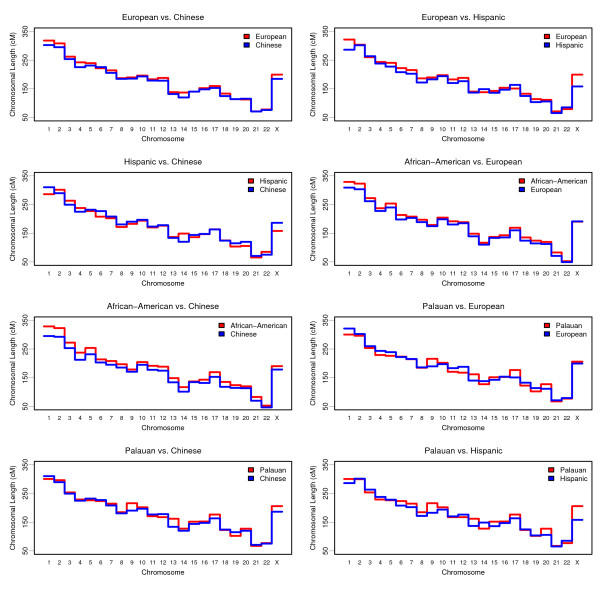
Chromosomal length comparisons between populations. The chromosomal lengths are depicted in different colors (red vs. blue) as shown in the legend. The chromosomal length is expressed in Haldane cM on the Y-axis, while the X-axis indicates chromosomes.